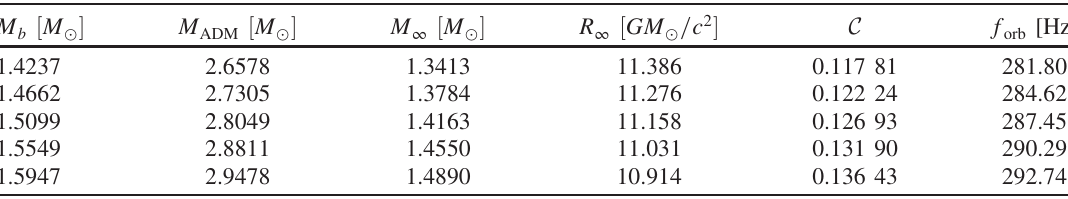
TABLE I. Properties of our initial data of equal-mass BNSs with the initial coordinate separation 45 km. Reported in the various columns are the baryon mass M b of each star, the Arnowitt-Deser-Misner (ADM) mass M system at initial data, the gravitational mass M ∞ of each star at infinite separation ( M ¼ 2 M ∞ ), the circumferential radius R ∞ of each star at infinite separation, the compactness C ≡ M ∞ =R ∞ , and the orbital frequency f initial